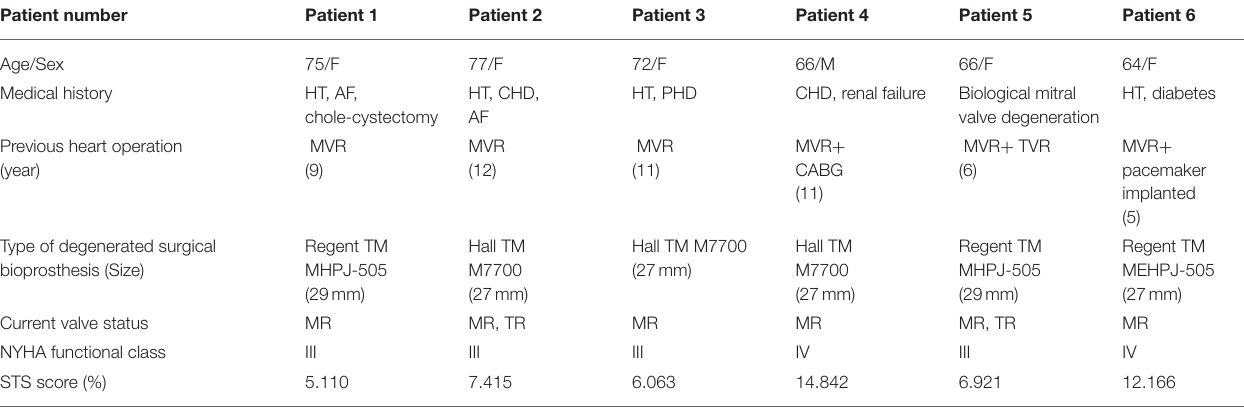
TABLE 2 | Demographics of patients undergoing transcatheter mitral valve implantation. Patient